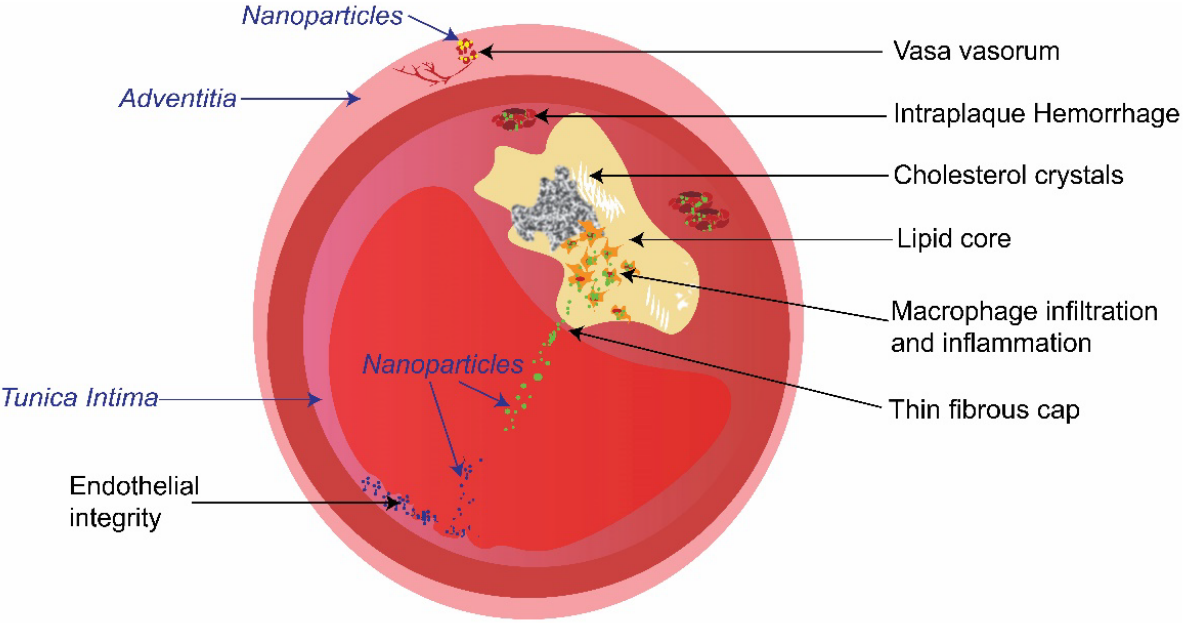
Figure 1. Schematic illustration of the cross-section of an atherosclerotic plaque in an artery. Key characteristics of the high-risk plaque (indicated by non-italic words in black), and typical intravascular targets of nanoparticles (nanoparticles targeting macrophages, endothelial cells, and vasa vasorum are represented by green, blue, and yellow dots respectively).